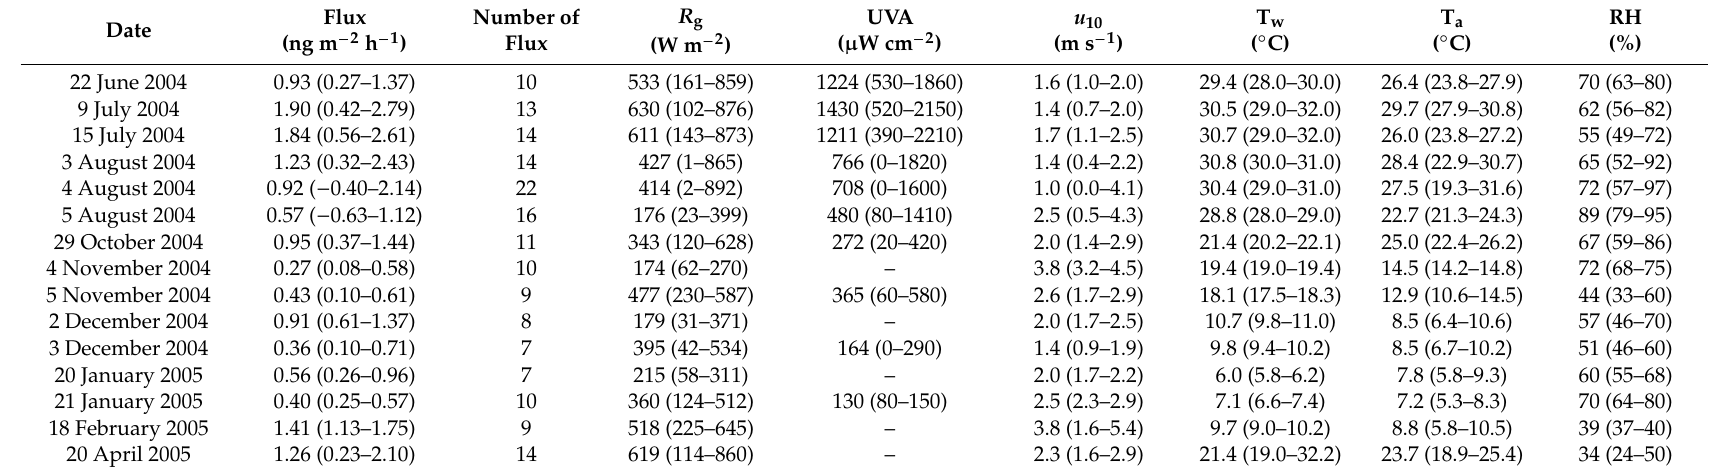
Table 2. Summary of the Hg air / water exchange fluxes at Cane Creek Lake (TN, USA) and meteorological